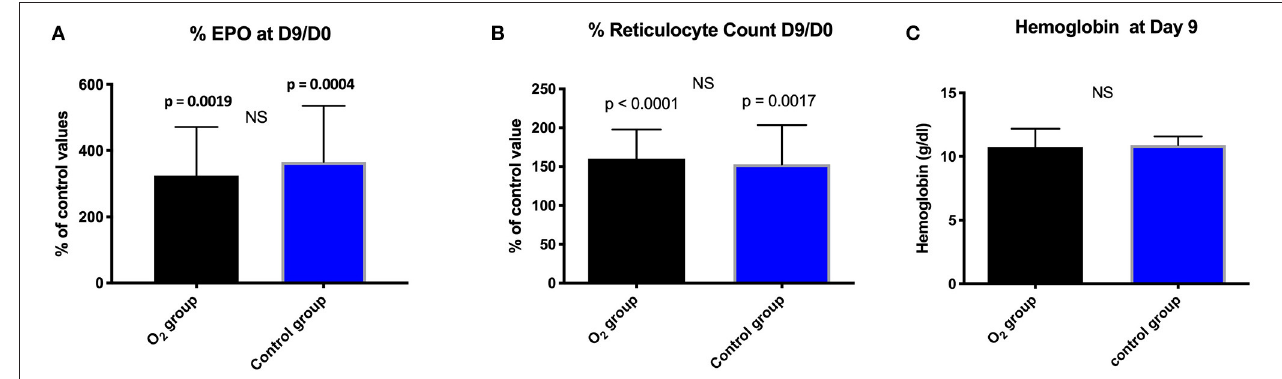
FIGURE 1 | Comparison between and within the groups in percentage: (A) EPO; (B) Reticulocyte count expressed as mean ± standard deviation at day 9 (D9) with respect to the baseline value (D0); (NS, non-significant). (C) : Evolution of hemoglobin (g/dl) expressed as mean ± standard deviation at day 9 in the two groups; (NS, not